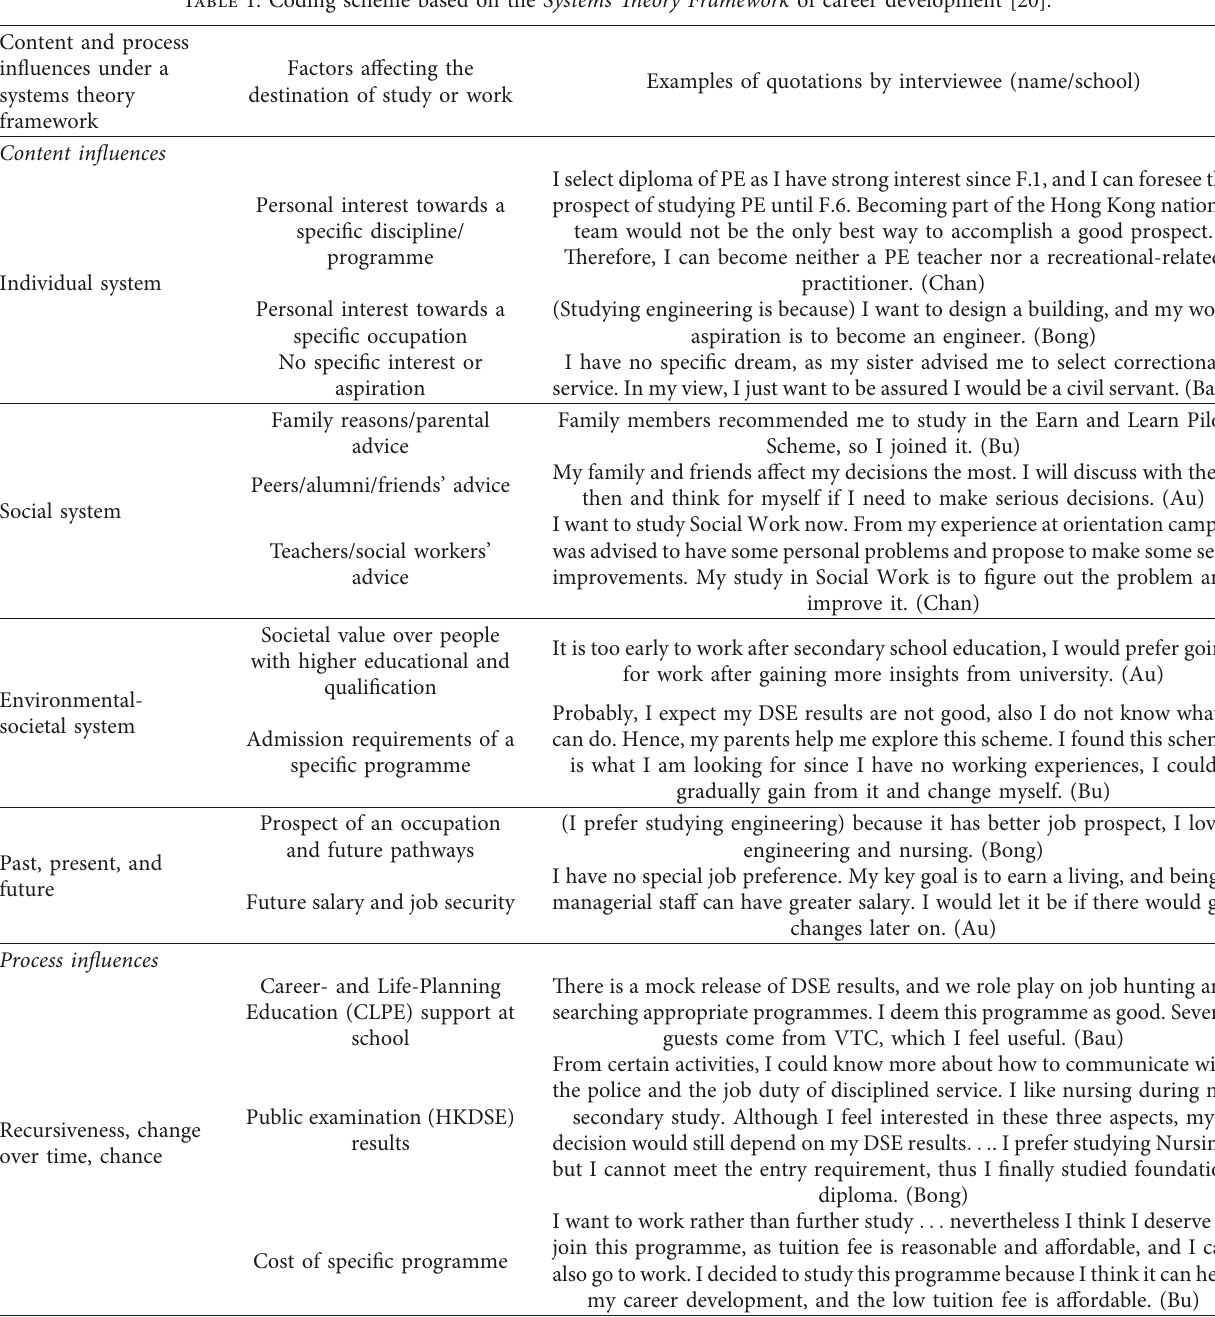
Table 1: Coding scheme based on the Systems Theory Framework of career development